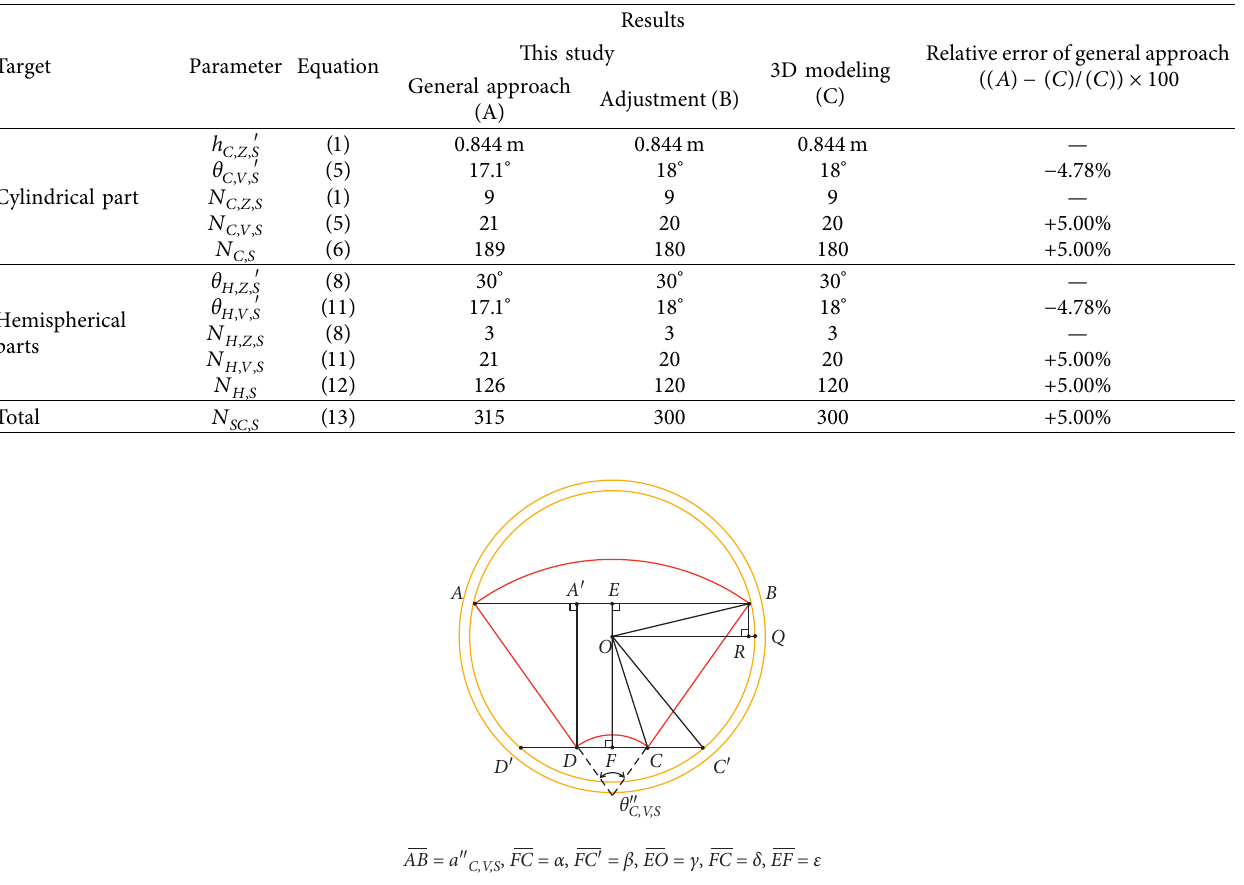
Figure 10: General top view of a finally segmented piece from the cylindrical part of a spherocylinder-type object depicted for deriving adjustment algorithm for errors induced by the virtual